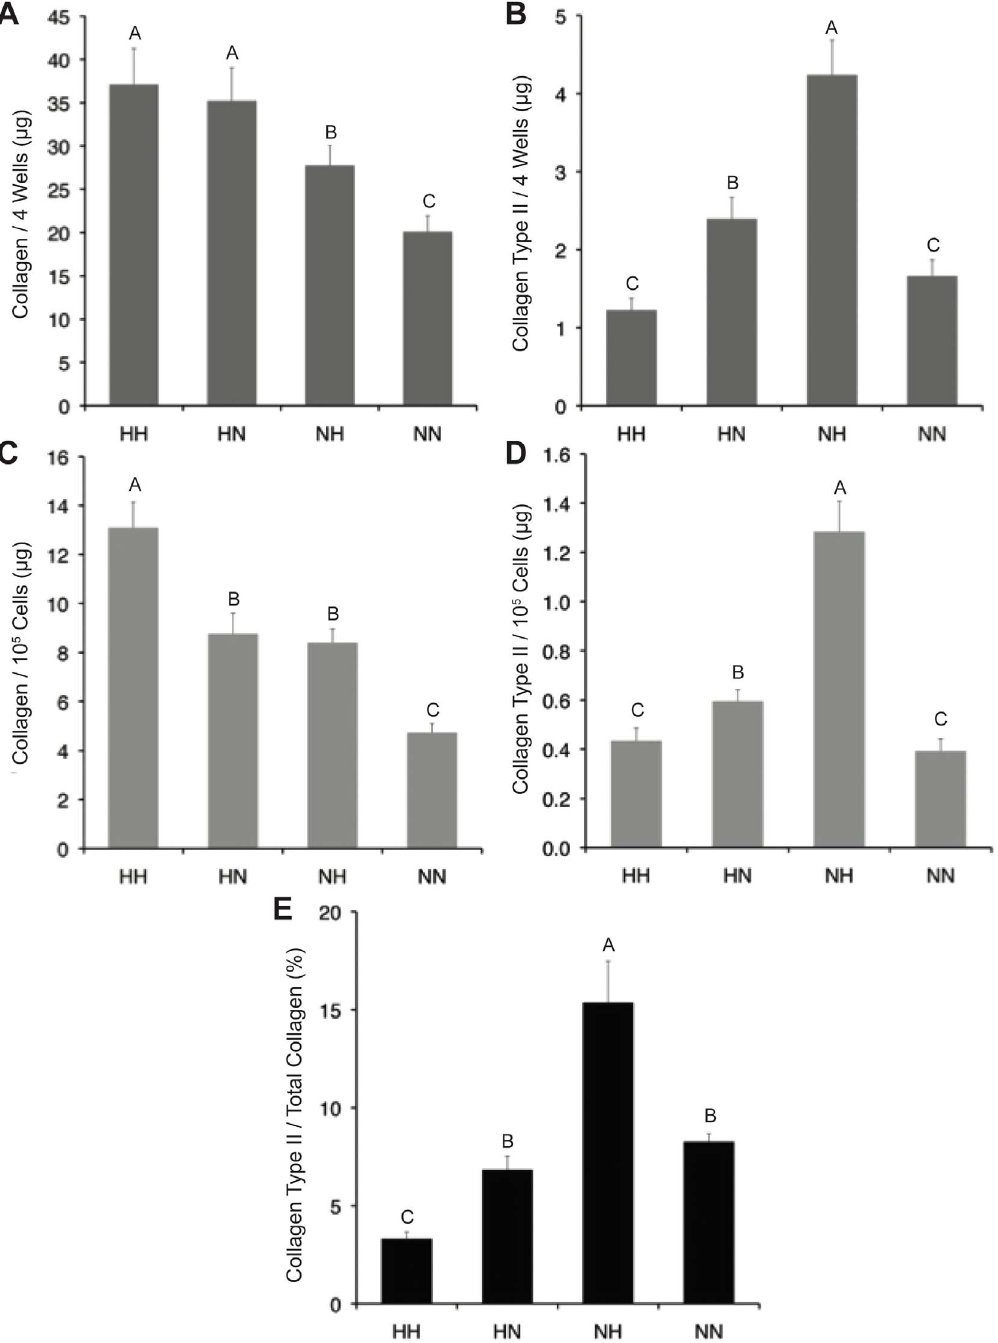
Figure 3. Collagen accumulation during micromass culture. Hypoxic expansion led to increased total collagen accumulation (A) and collagen accumulation per cell (C) during differentiation. Overall collagen type II production was greatest in the NH group (B) as was collagen type II production per cell (D) and relative to total collagen production (E). Data are mean 6 S.D. Groups not connected by letters are significantly different. Significance defined as p ,